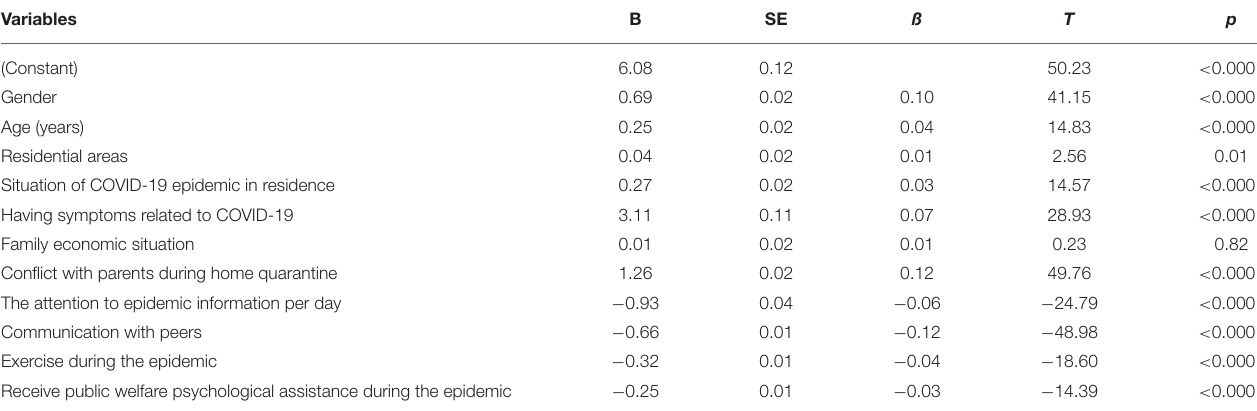
TABLE 4 | Results of multiple linear regression analysis of influencing factors for anxiety